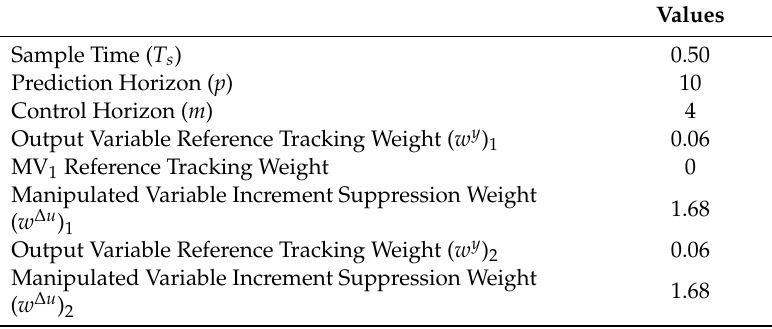
Table 3. Model predictive control design parameters.